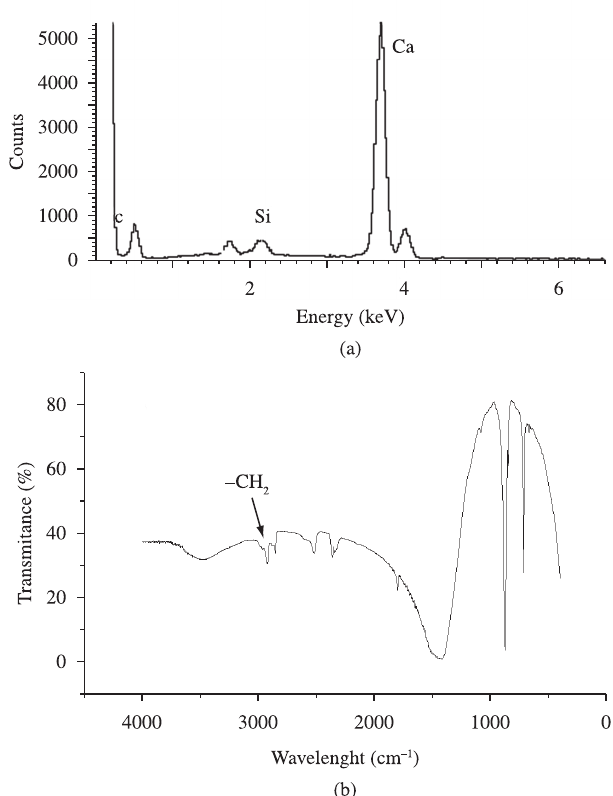
Table 1. Mechanical properties of PP/CaCO